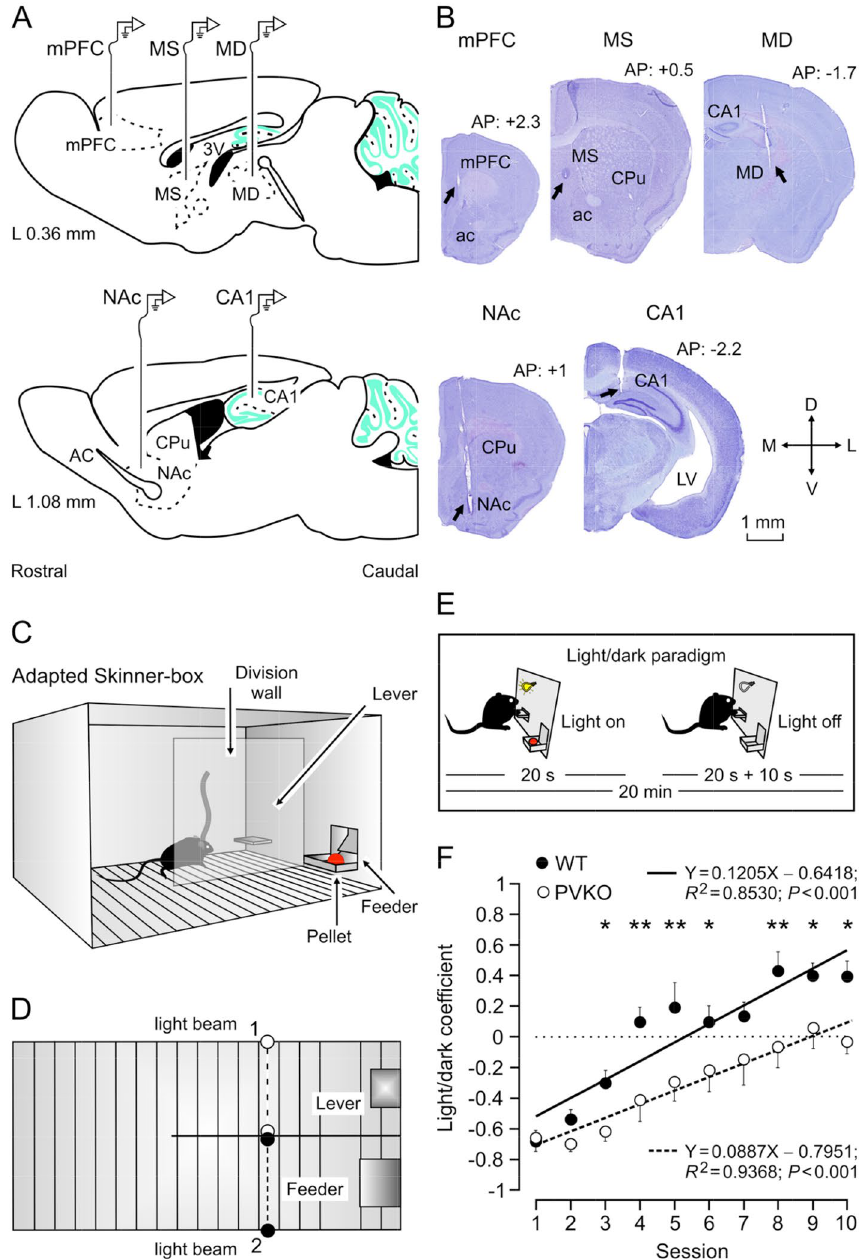
Figure 1. Experimental design and mice performance during the light/dark conditioning paradigm. ( A ) Mice were chronically implanted with single recording electrodes at medial prefrontal cortex (mPFC), medial septum (MS), mediodorsal thalamic nucleus (MD), nucleus accumbens (NAc), and the CA1 area of the dorsal hippocampus (CA1). ( B ) Representative photomicrographs of electrodes implanted in the five recording sites (arrows). Scale bar, 1 mm. ac, anterior commissure; LV lateral ventricle; CPu caudate-putamen; AP anterioposterior; D dorsal; L lateral; M medial; V ventral. ( C ) Mice were trained in a modified Skinner box with a Perspex division wall separating the lever from the feeder. ( D ) Each corridor of the modified Skinner box was provided with a light beam located ≈ 6 cm from the lever (1) or the feeder (2). At first, all mice (n = 6 WT and n = 6 PVKO) had to acquire a fixed-ratio (1:1) schedule until reaching the criterion set to press the lever for at least 20 times during a 20 min session for 2 successive days. ( E ) After reaching the criterion, the mice were transferred to a light/dark paradigm in which lever presses were reinforced only when a light bulb was switched on. Lever presses performed during the dark period delayed the lighted period for up to an additional 10 s. ( F ) Performance of WT (black dots) and PVKO (white dots) mice (n = 6 per group) during the light/dark test. The light/dark coefficient was calculated according to Eq. (1) (see “Materials and methods”). Values are mean ± SEM (* P < 0.05 ; ** P < 0.01 ). Best linear adjustments to both set of data are illustrated (for more details see Supplementary Table